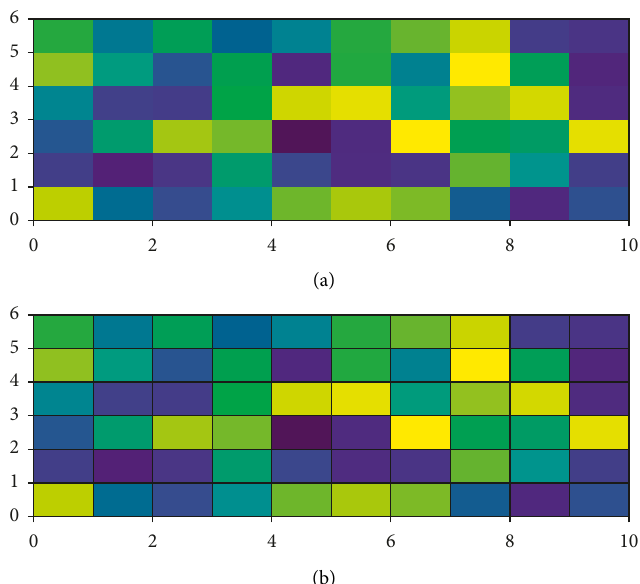
Figure 2: Schematic diagram of the convolution field of a cavity. (a) Normal convolution. (b) Convolution with an expansion factor of 2.